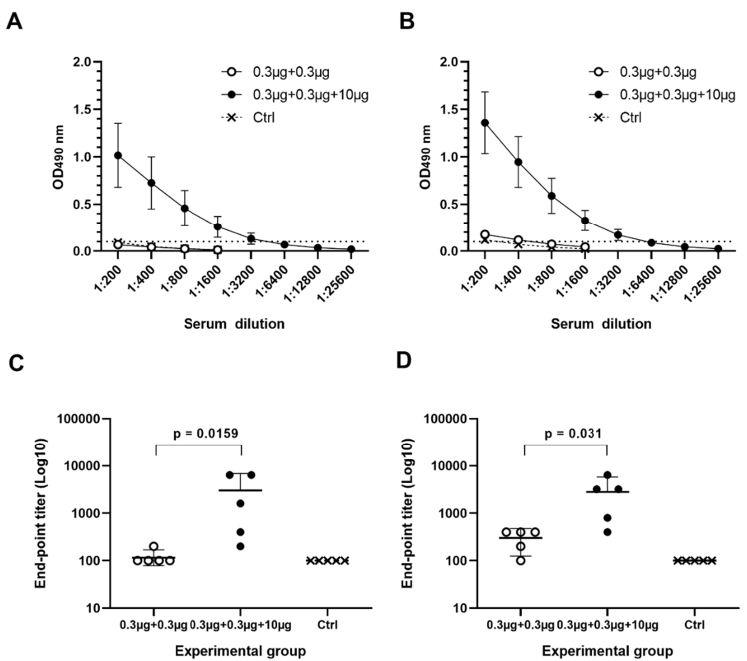
Figure 2. Serum norovirus (NoV)-specific IgG titration. Individual termination serum of each mouse in experimental groups immunized with 0.3 µg NoV VLPs alone or mixed with 10 µg of VP6, and the control group (Ctrl, PBS only) were two-fold diluted for analyzing NoV ( A ) GI.4- and ( B ) GII.4-2006a-specific IgG antibodies. Shown are mean titration curves for each group and standard errors of the mean. Dashed line indicates positivity cut-o ff (OD > 0.1). IgG end-point titers against ( C ) GI.4 and ( D ) GII.4-2006a VLPs were determined as the reciprocal of the highest serum sample dilution giving a positive reading. Shown are geometric mean titers with 95% confidence interval of each group. Groups were compared by Mann–Whitney U-test and p values were